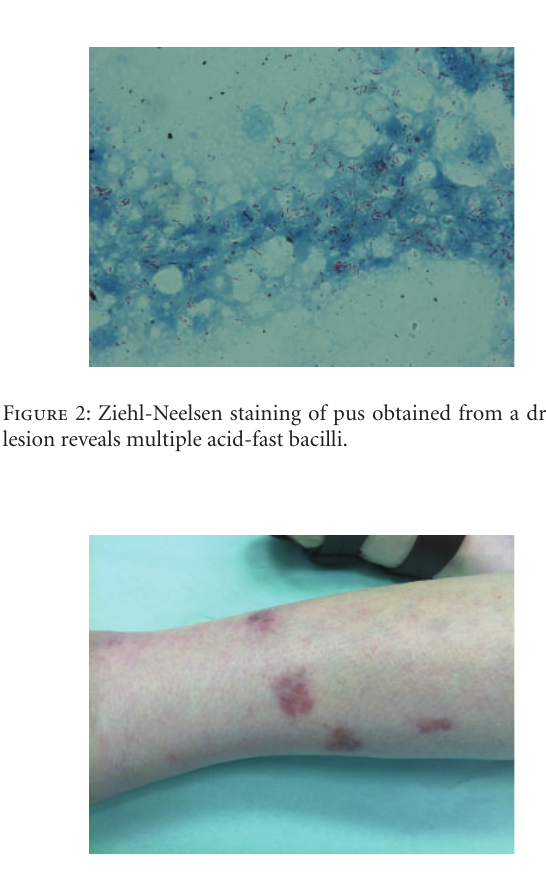
Figure 3: Photograph taken 6 months after treatment shows heal- ing of the skin lesions with complete cessation of discharge and resi- dual